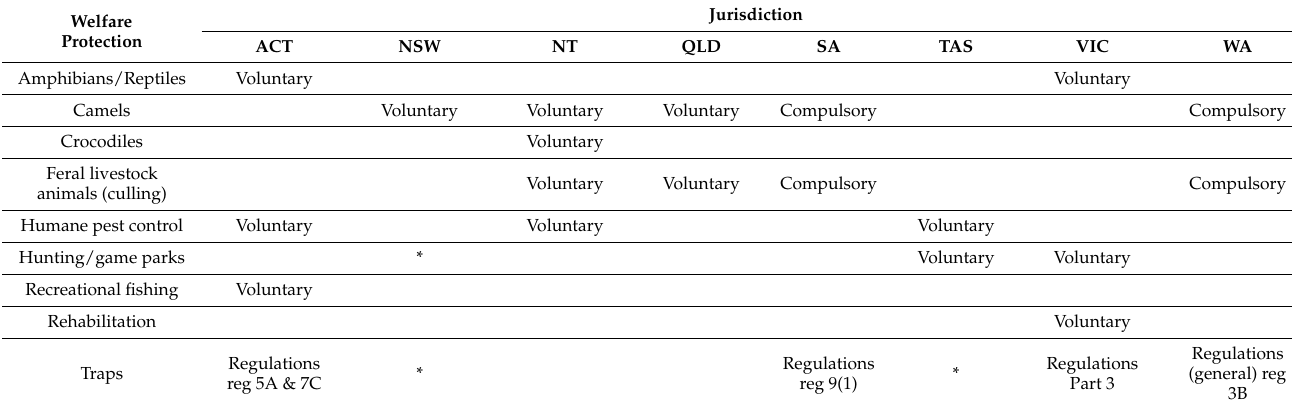
Table 5. Areas of welfare protection assigned to wild and exotic animals in captivity via subordinate legislation in each Australian jurisdiction. The terms ‘compulsory’ and ‘voluntary’ refer to the status of the code of practice. For a detailed list of all compulsory and voluntary codes, refer to, Appendices A and B respectively. This table is not intended to be an exhaustive list of all areas of wild animal protection, just of those areas that were identified from the search strategies.